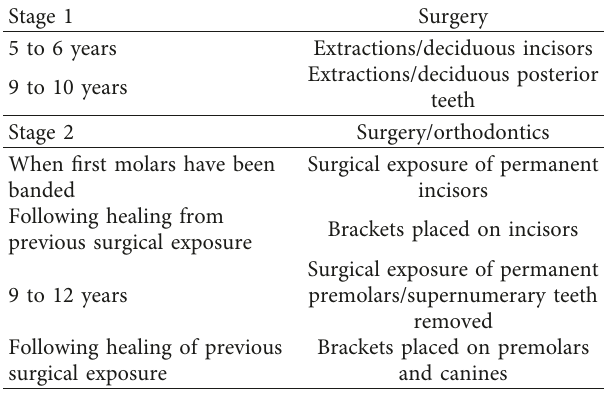
Table 2: Multiple surgery approach (Toronto-Melbourne).